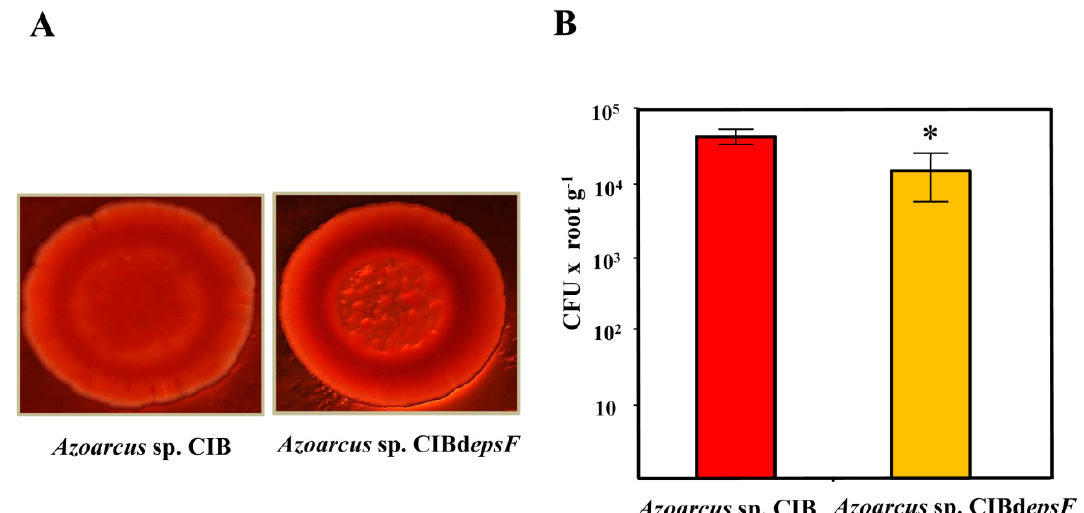
Figure 3. Colony morphology and rice colonization capacity of the Azoarcus sp. CIB and Azoarcus sp. CIBd eps F strains. ( A ) Morphology of the colonies of Azoarcus sp. CIB (pSEVA237) and Azoarcus sp. CIBd epsF strain grown in VM solid medium supplemented with Congo red (0.5 g L − 1 ). The colonies were visualized with a Leica MZ16FA stereomicroscope. ( B ) Quantification of the number of endophytes recovered from rice roots after inoculation with Azoarcus sp. CIB (pSEVA237) and Azoarcus sp. CIBd epsF strains. Graph shows the CFU values per gram of root (fresh weight) of three independent experiments ± standard deviation. An asterisk means a significant difference ( p = 0.0375), according to paired t -test.